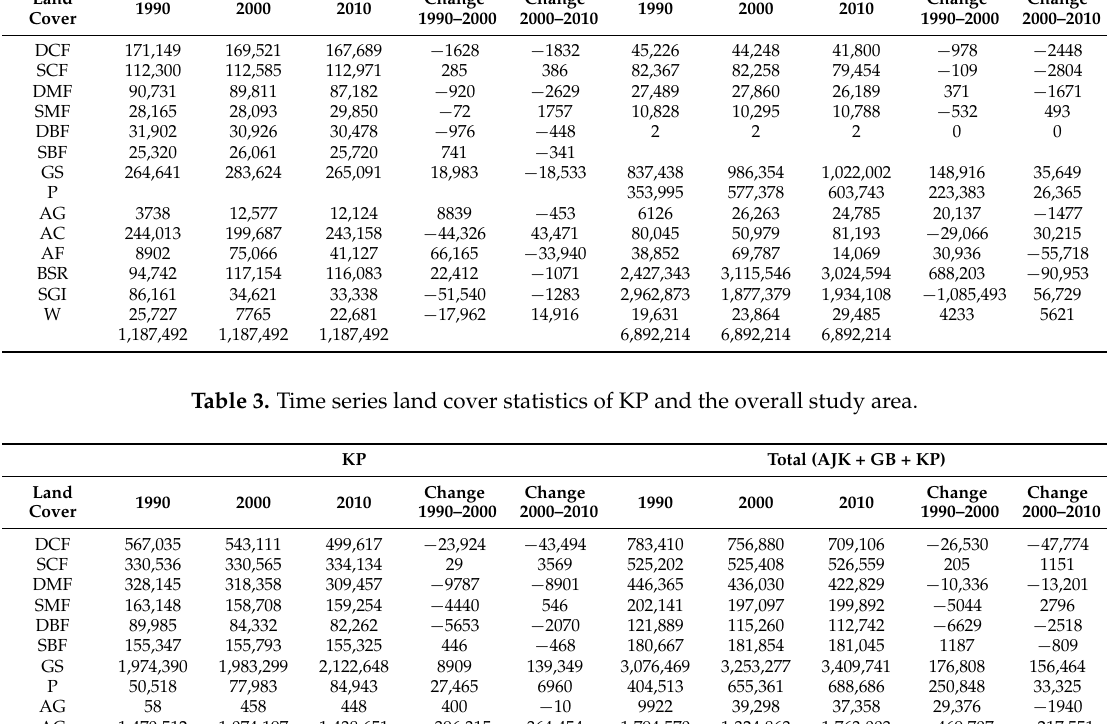
Table 2. Time series land cover statistics of Azad Jammu and Kashmir (AJK) and Gilgit-Baltistan (GB). AJK GB